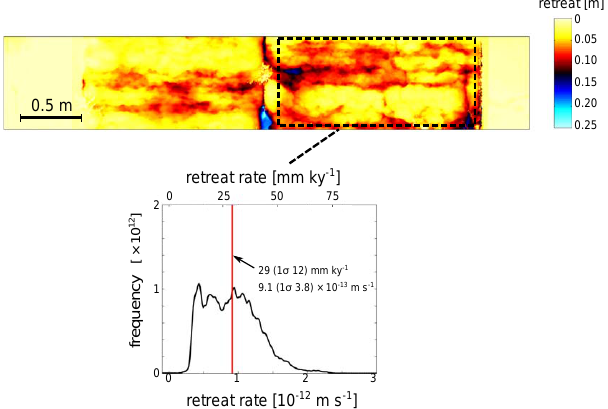
Figure 2. Surface retreat map and associated retreat rate spectrum for a section of the Western Wall. The retreat rate is calculated rel- ative to a false datum reconstructed from well-preserved blocks flanking the eroded region. Data from Emmanuel and Levenson